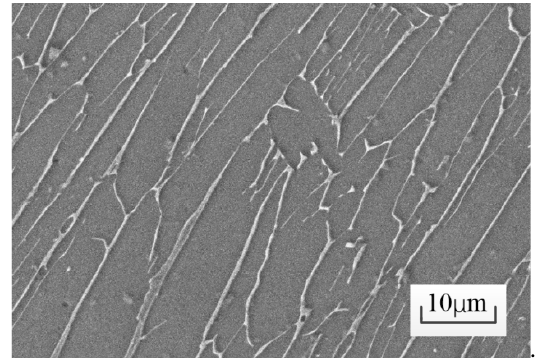
Figure 6. Microstructure of Ti-6Al-4V. Adapted from [34], with the permission from Elsevier, 2020. Table 1. Physical and mechanical properties of Ti-6Al-4V alloy at room temperature.